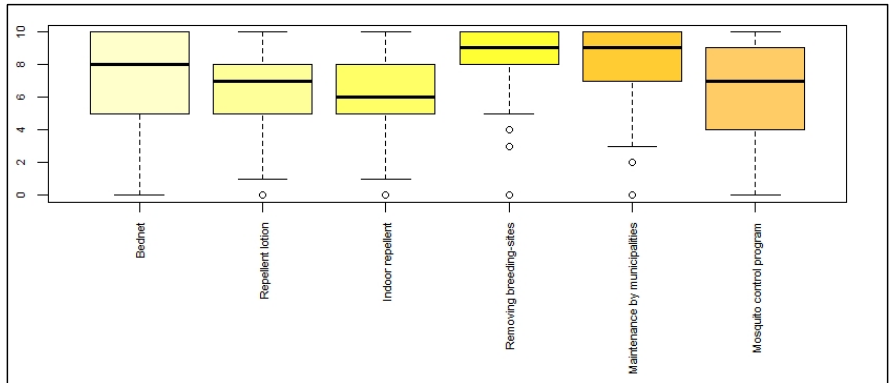
Figure 6. Perception of efficiency of different protective measures against mosquito bites.